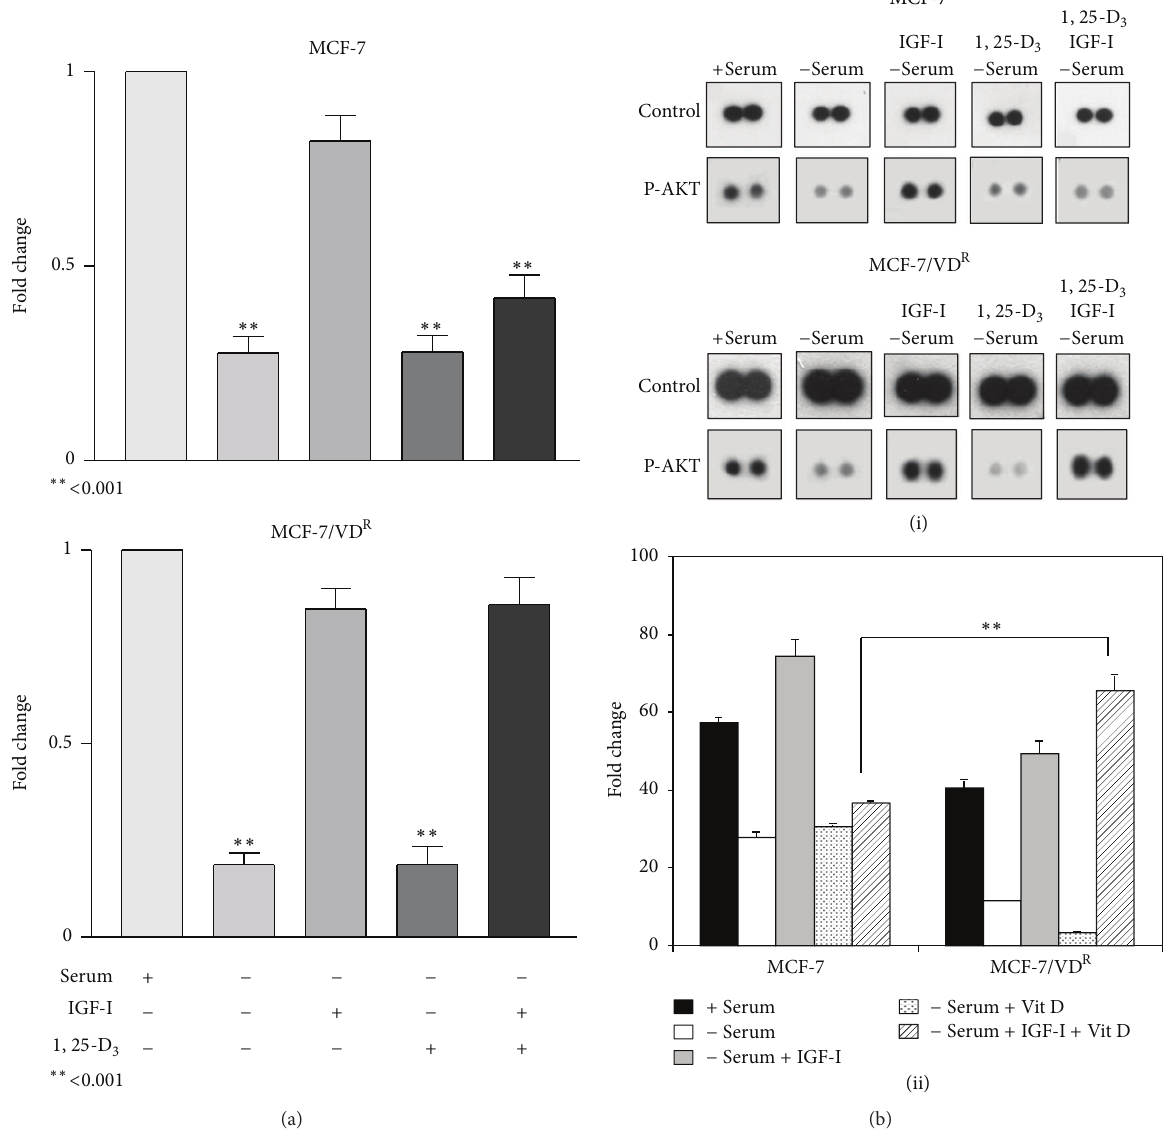
Figure 3: Modulation of IGF-induced Akt phosphorylation in response to 1, 25-D 3 treatment in MCF-7 and MCF-7/VD R cells. (a) MCF-7 and MCF-7/VD R cells were treated with 100 nM 1, 25-D 3 or 30nM IGF-I, alone or in combination in serum-free medium. Cells were also cultured in medium supplemented with 2% serum as a control. After 6 days of treatment, cell viability was estimated by neutral red assay. ∗ 𝑃 < 0.05 and ∗∗ 𝑃 < 0.001 are statistically significant compared to control. Means of 3 separated experiments are shown ( 𝑛 = 12 ). (b) (i) MCF-7 and MCF-7/VD R cells were treated with 100nM 1, 25-D 3 or 30 nM IGF-I, alone or in combination, in serum-free medium. After 5 days of treatment, whole cell extracts were prepared and analysed on a phospho-MAPK antibody array (R&D Systems, UK) following manufacturer’s instruction. (ii) Densitometric analysis of Akt phosphorylation. Data shown are means of 3 replicates, significantly different from parental cells. ∗∗ 𝑃 < 0.001